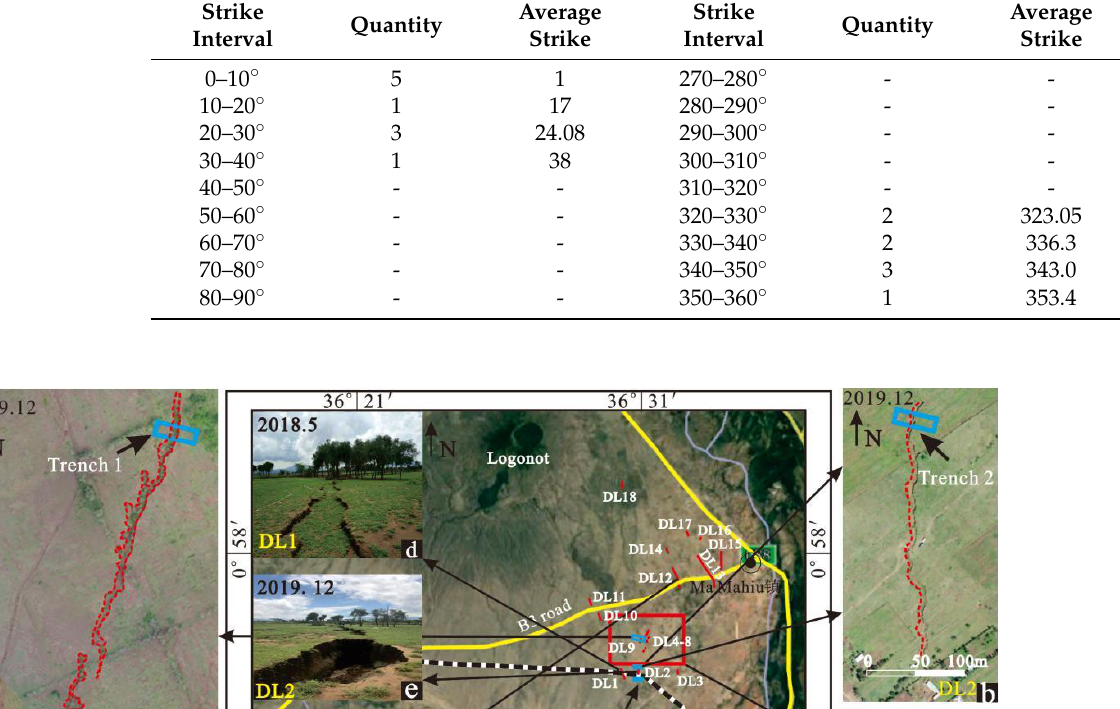
Table 4. Ground fissure strike statistics.